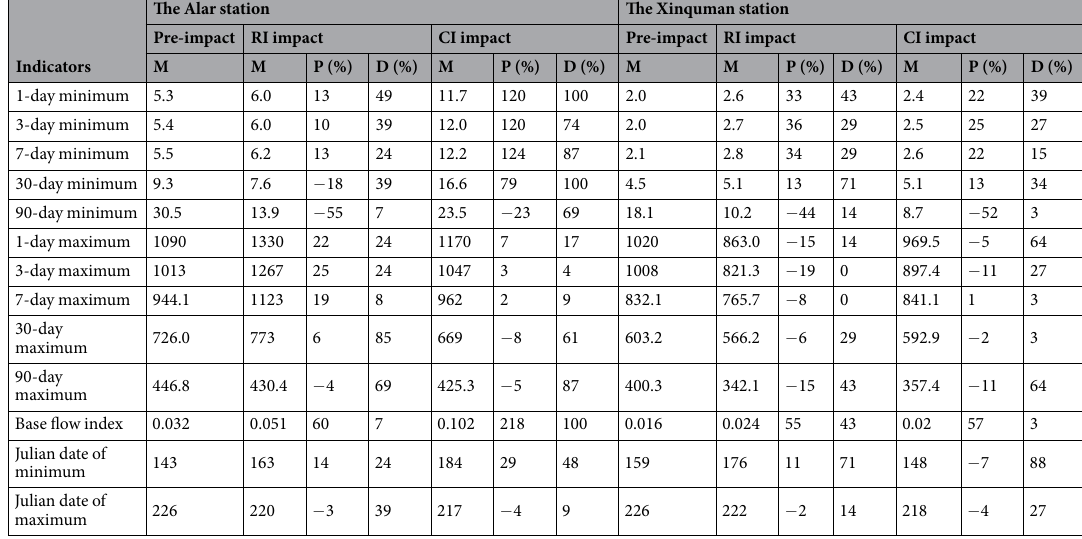
Table 2. Comparison of hydraulic alterations in extreme flow conditions (Groups 2 and 3) at the two stations for the pre-impact, RI impact and CI impact. Note: M for median value, P for deviation degree estimated using Equation (1), D for degree of hydrological alteration estimated with Equation (2), RI for Reservoir irrigation, and CI for Channel